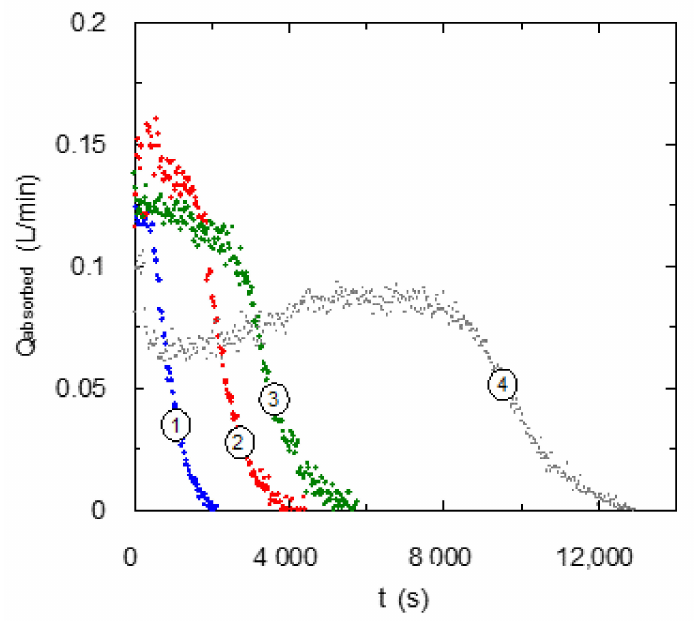
Figure 3. Influence of TMEDA concentration upon carbon dioxide absorption curve. Q G = 0.2 L · min − 1 . 1 (cid:13) C B = 0.1 mol · L − 1 ; 2 (cid:13) C B = 0.2 mol · L − 1 ; 3 (cid:13) C B = 0.3 mol · L − 1 ; 4 (cid:13) C B = 0.6 mol · L − 1